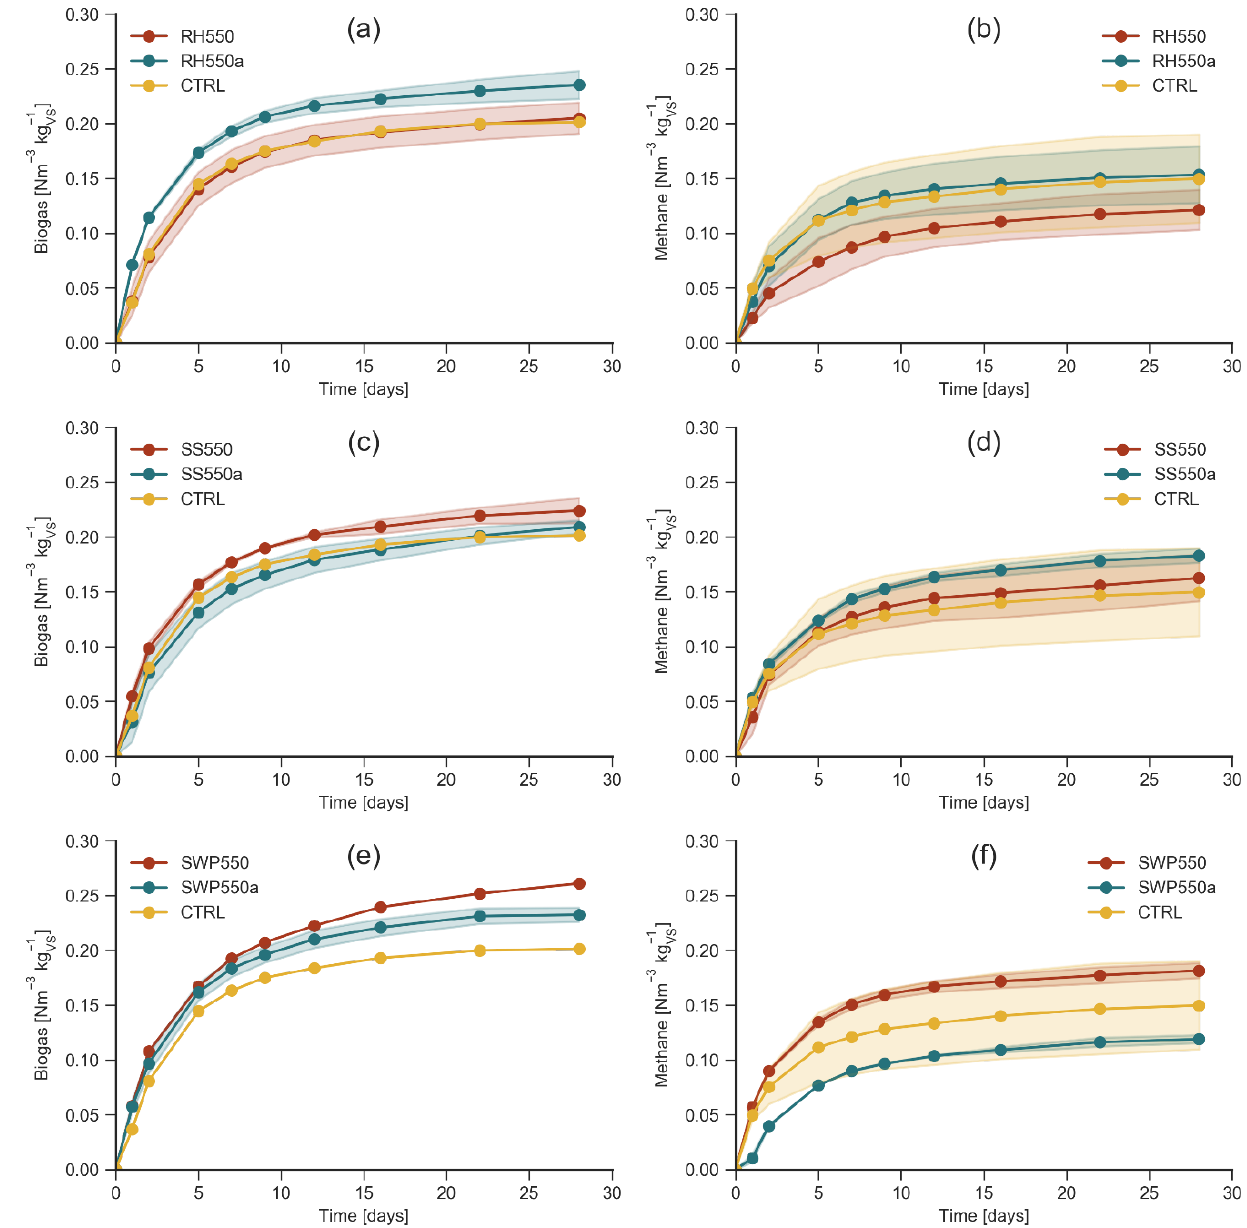
Figure 1. Cumulative biogas and methane productions from the AD of mixed sludge with BCs addition: ( a ) Biogas production of RH550, RH550a, and CTRL groups; ( b ) Methane production of RH550, RH550a, and CTRL groups; ( c ) Biogas of SS550, SS550a, and CTRL; ( d ) Methane of SS550, SS550a, and CTRL; ( e ) Biogas of SWP550, SWP550a, and CTRL; ( f ) Methane of SWP550, SWP550a, and CTRL.